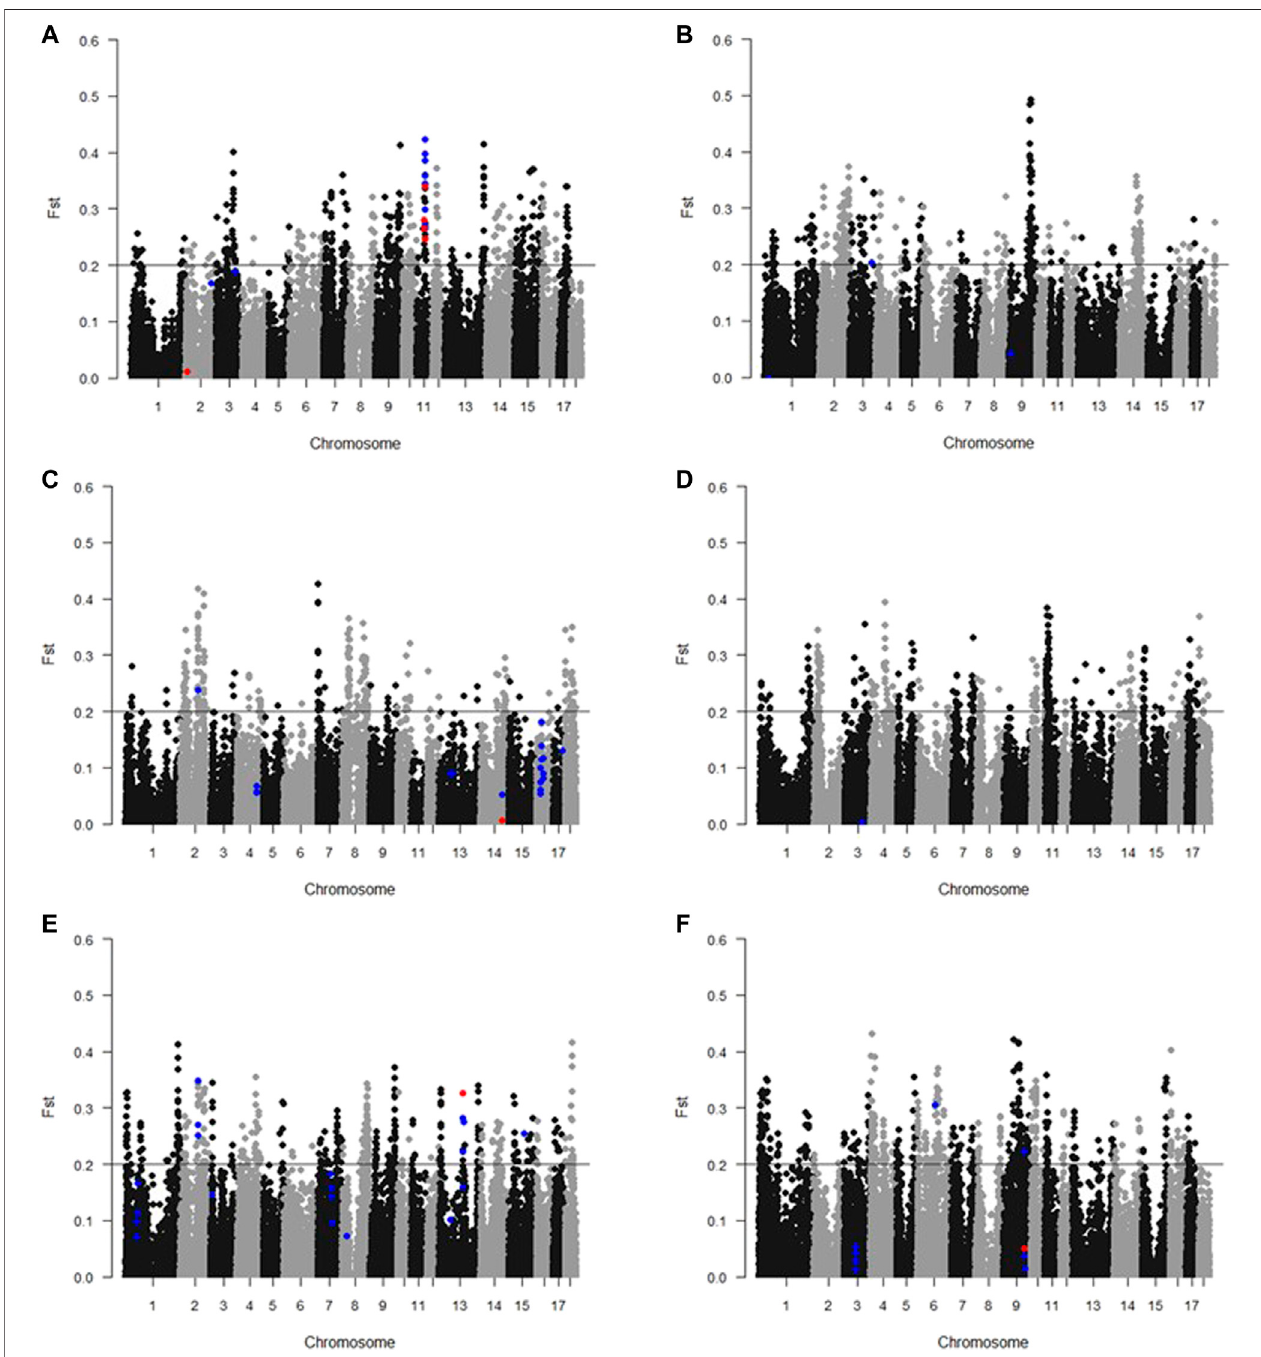
FIGURE 2 | Manhattan plots of F S T of meat color. (A) L* 45 min; (B) L* 24 h; (C) a* 45 min; (D) a* 24 h; (E) b* 45 min; (F ) b* 24 h. The x -axis indicates the chromosome (1-18) where the SNPs were located, and y -axis denotes the F ST value. The line represents the threshold of differentiation (F ST = 0.2). Blue dots and red dots represent SNPs that reached the suggestive signi fi cance threshold and genome-wide signi fi cance threshold, respectively.